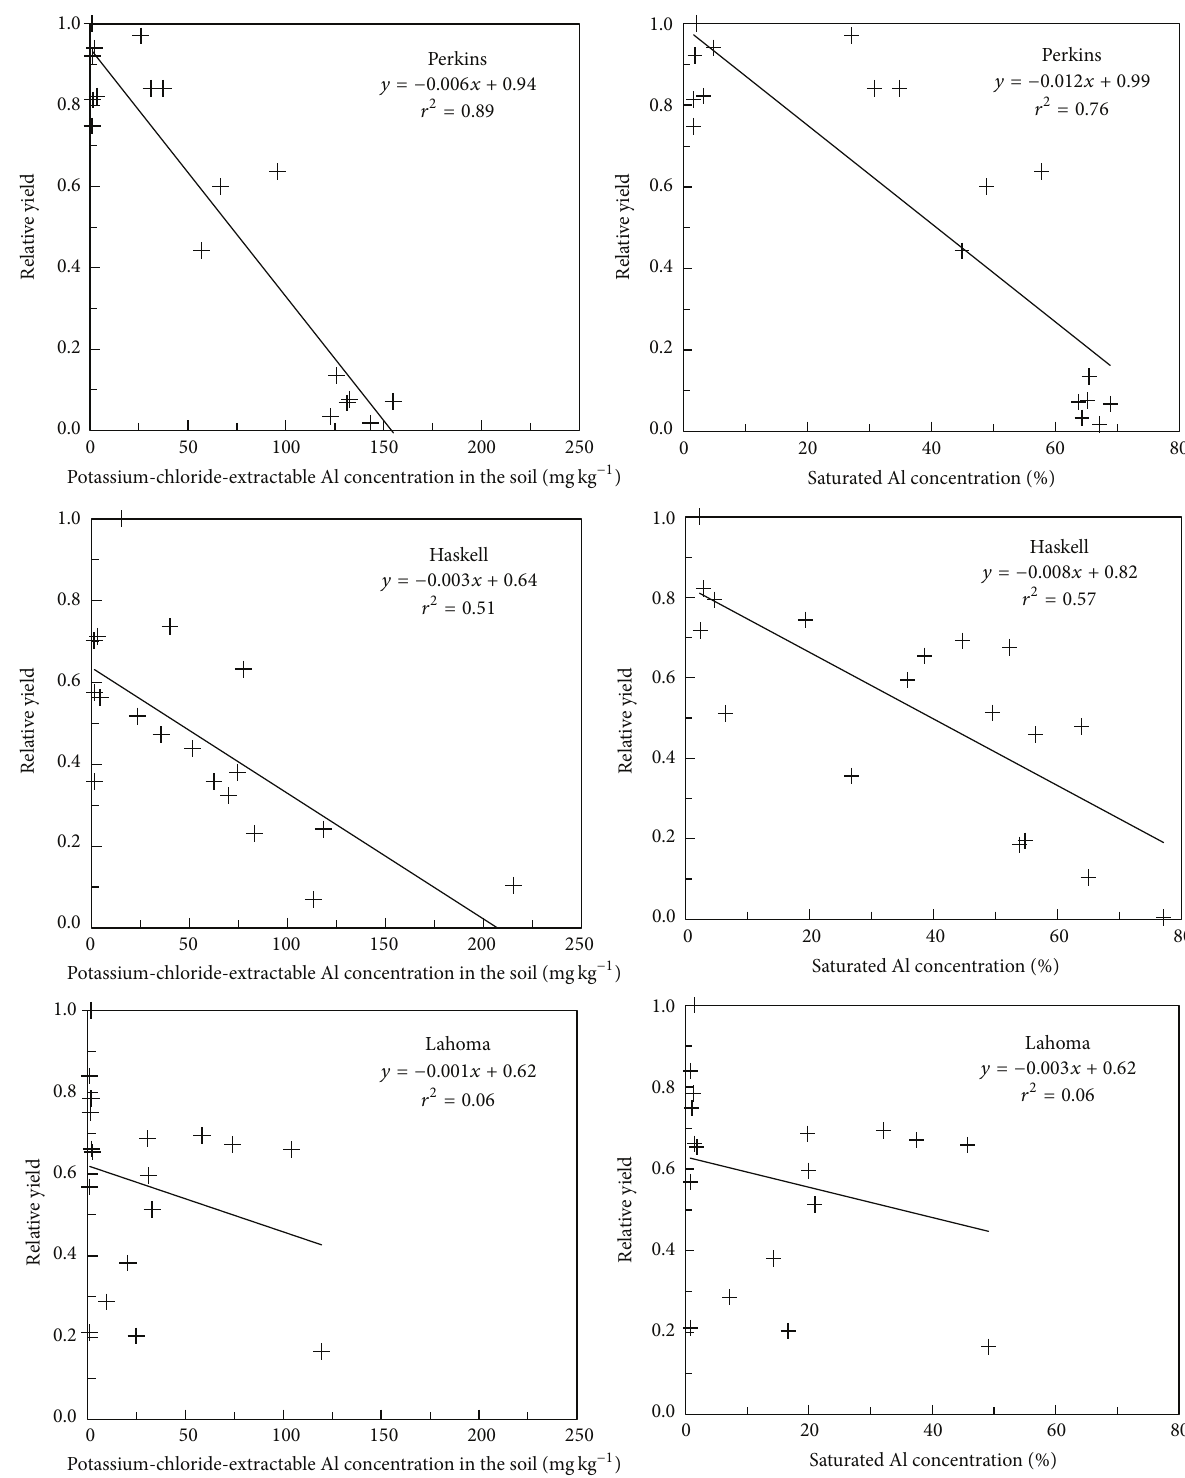
Figure 8: Relative sunflower seed yield as a function of potassium-chloride-extractable aluminum concentration (mgkg −1 ) and aluminum saturation (%) in the soil at Perkins, Haskell, and Lahoma, Oklahoma, in